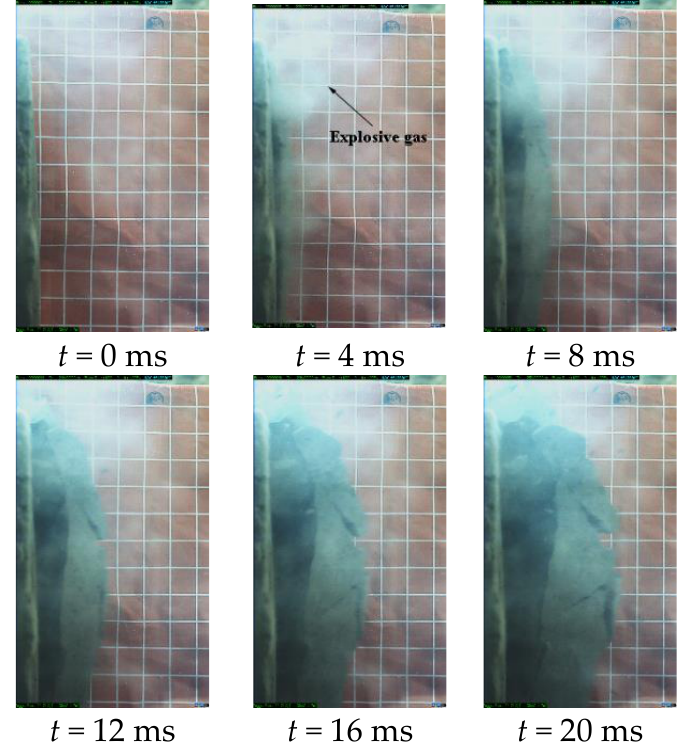
Figure 8. Space position of rock at different time.